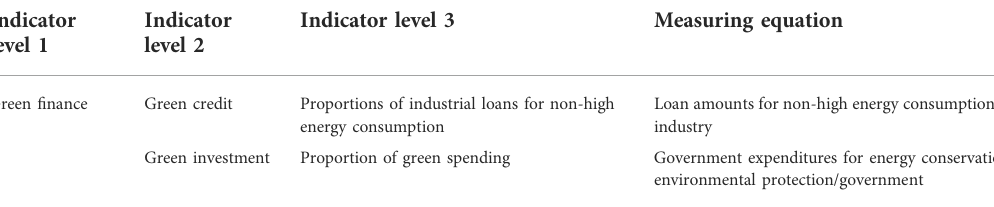
TABLE 1 Indicator systems of green fi nance.